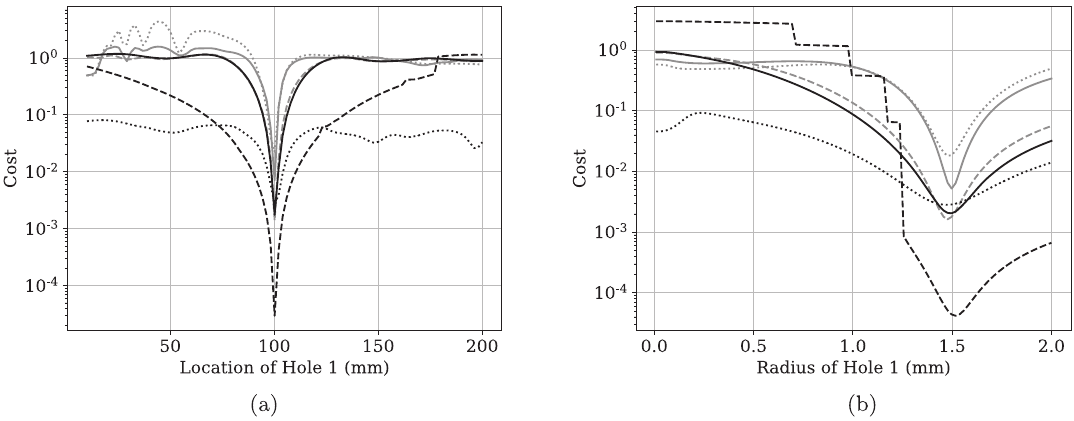
Figure 4. Costs evolution for different observables computed for frequencies in [0.1, 4] kHz with a 2 Hz step, for the fi ngering “ oxxx ” with respect to: (a) the location and, (b) the radius of the fi rst hole. The observables are: the complex value (solid lines), the modulus (dotted lines) and the phase (dashed lines) of the impedance (gray) and the re fl ection coef fi cient